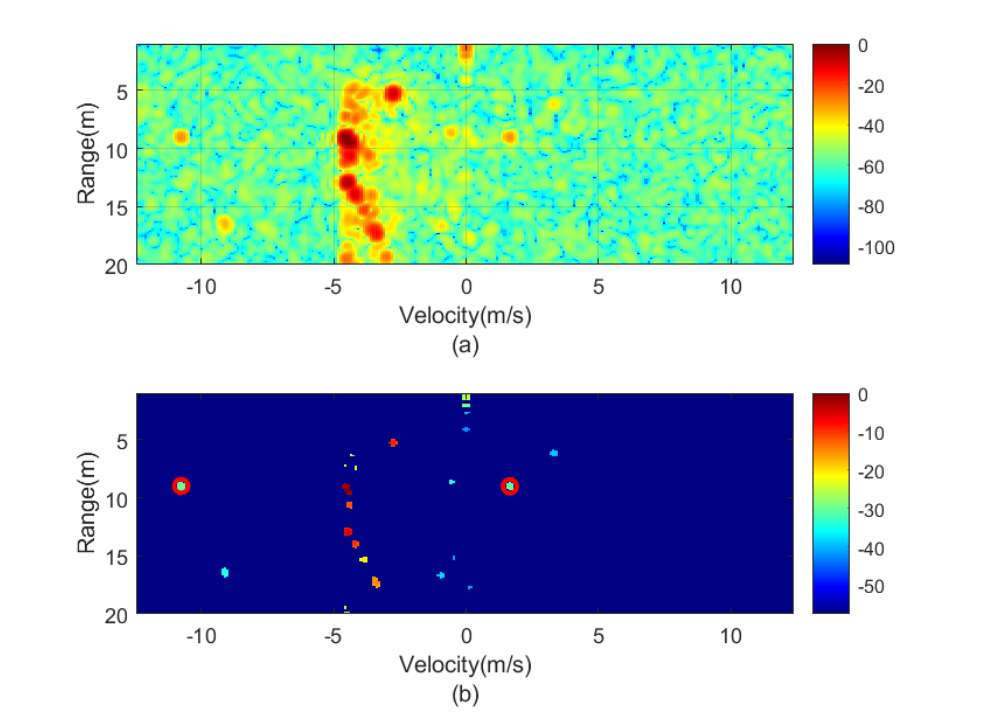
Figure 12. Measured range—Doppler map ( a ) and detection after CFAR processor ( b ) for the transponder modulated at 1000 Hz for a distance of about 5 m.